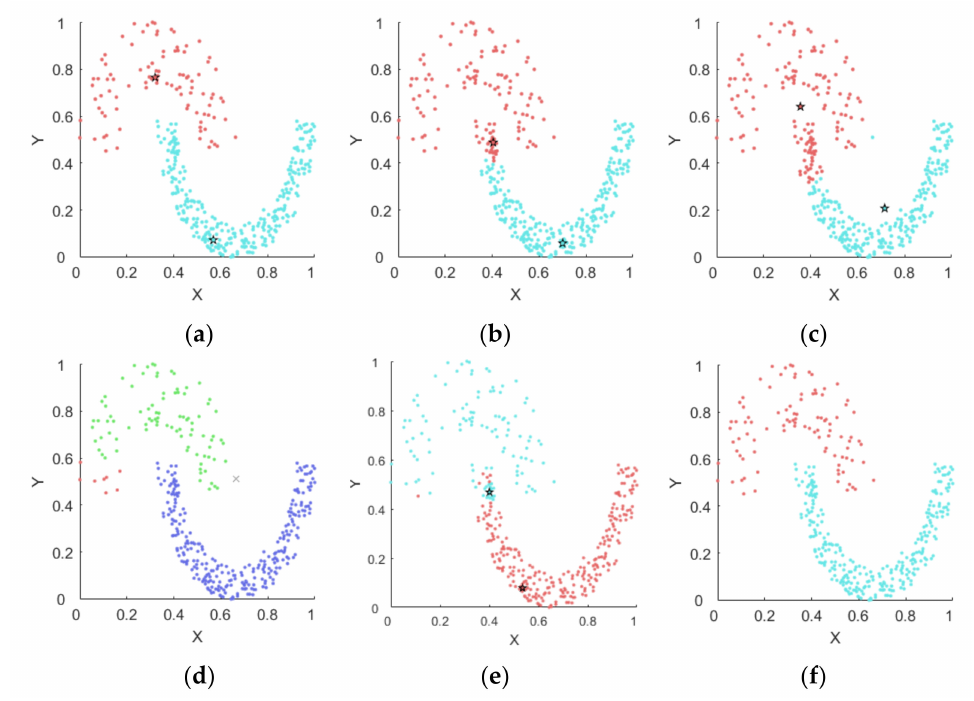
Figure 6. Results on Jain. ( a ) ConDPC, ( b ) DPC, ( c ) K-means, ( d ) DBSCAN, ( e ) DPC-DBFN, ( f )